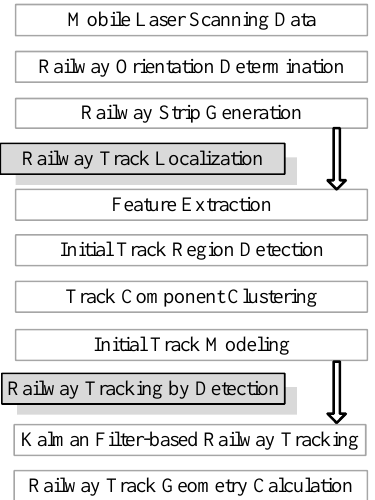
Figure 1. Overall workflow of proposed methods for railway tracking in the Kalman Filter framework.